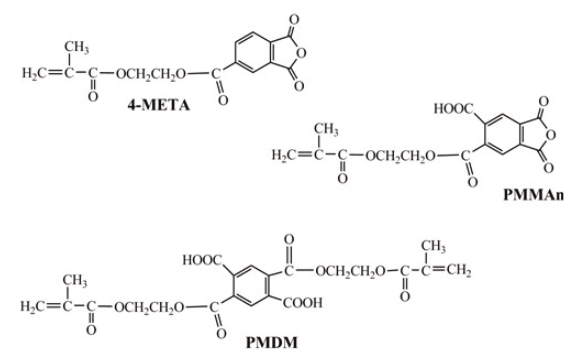
Figure 1: Structure of PMDM, 4-META and PMMAn adhesive